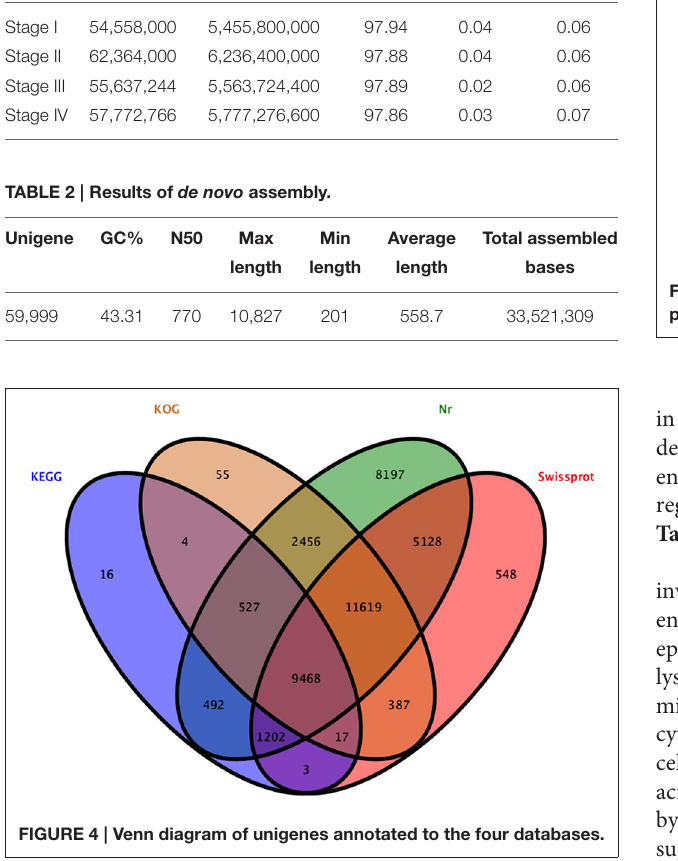
and more than 40% of them displayed high homology (1e < 10 − 50 ) to known sequences. GO classification and KOG function classification of all the unigenes are shown in Figure S2 .